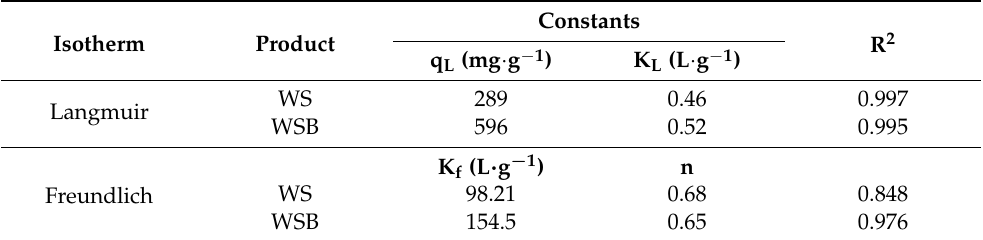
Figure 6. Langmuir ( a ) and Freundlich ( b ) isotherms of metribuzin. Table 3. Adsorption isotherm parameters for metribuzin on WS and